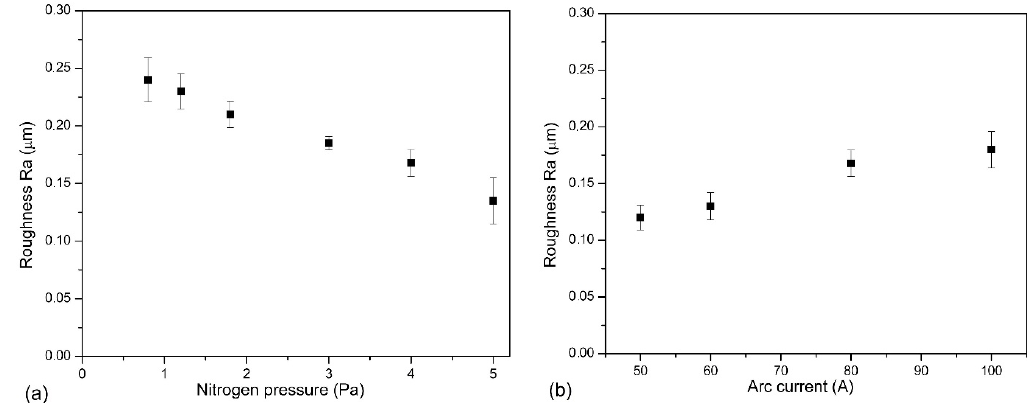
Figure 7. Roughness parameter Ra of AlCrN coatings formed at: ( a ) various pressure of nitrogen, ( b ) various arc current.